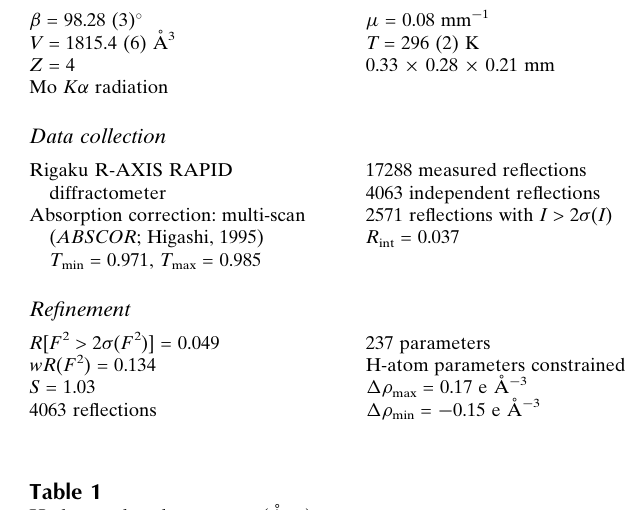
Hydrogen-bond geometry (A˚ , (cid:1)